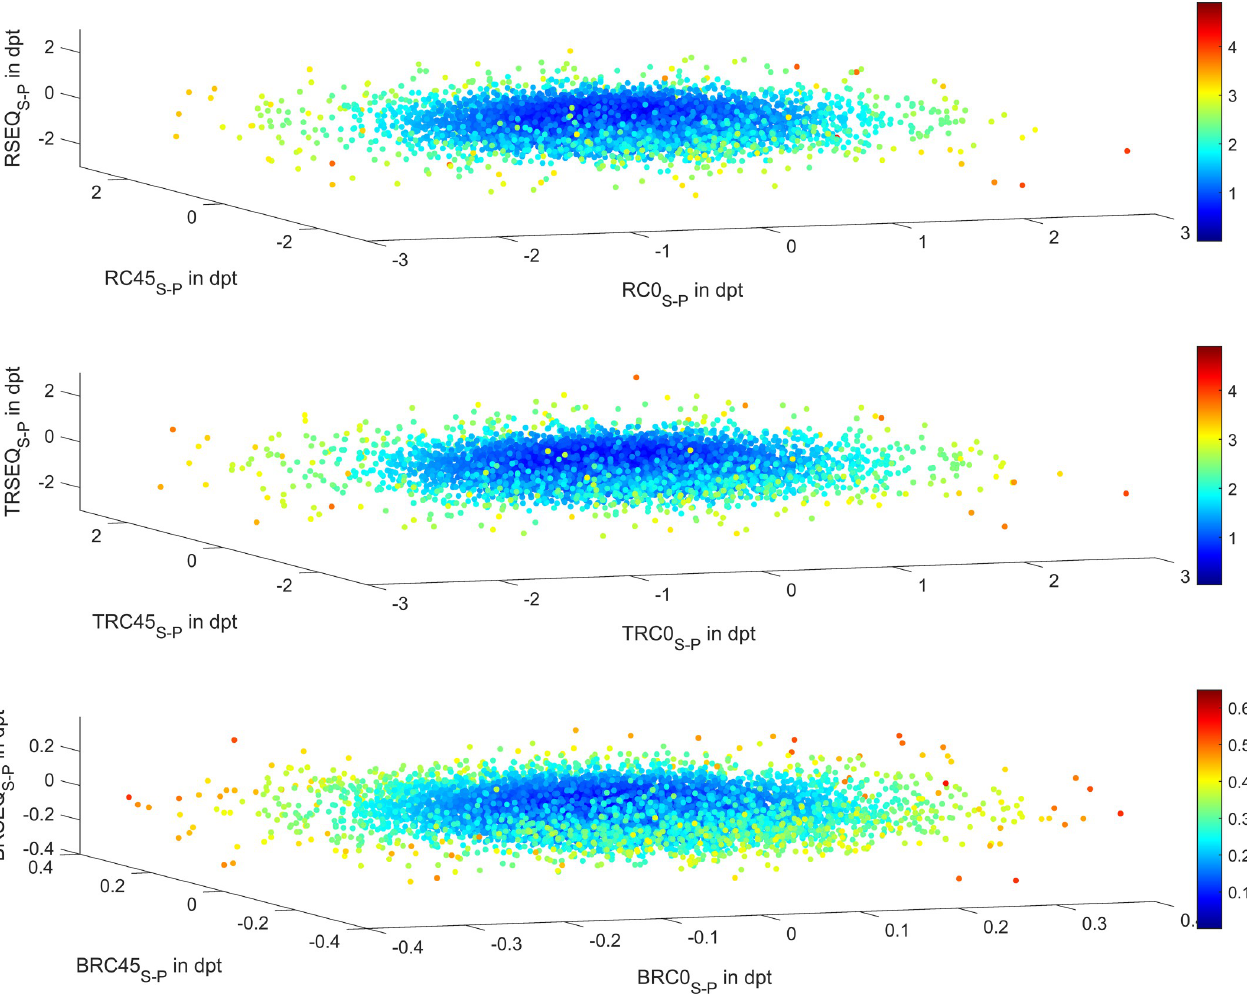
Fig 2. Difference of the power vector components comparing both eyes of the individuals (secondary eyes minus primary eyes) for keratometry (upper graph), total keratometry (middle graph), and corneal back surface (lower graph). The Euclidian norm of the power vector is colour-coded as indicated in the colour scale on the